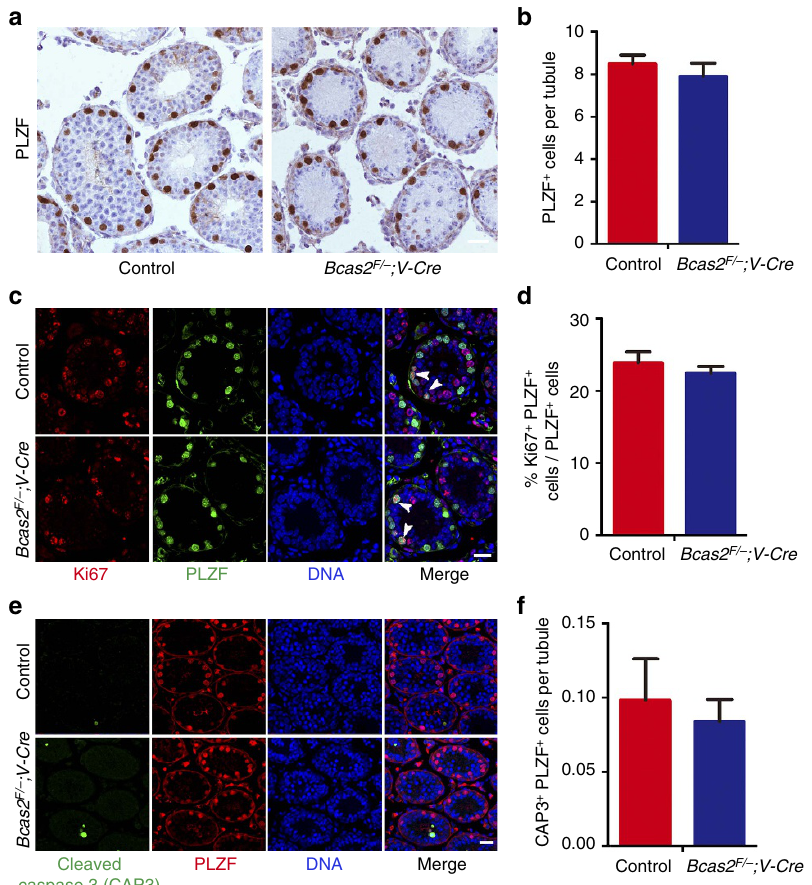
Figure 4 | Proliferation and apoptosis assay of spermatogonia. ( a ) Immunohistochemical assay of PLZF in control and Bcas2 F/ (cid:2) ;Vasa-Cre testes at P12. The DNA was stained with hematoxylin. Scale bar, 25 m m. ( b ) The number of PLZF þ cells per seminiferous tubules in control and Bcas2 F/ (cid:2) ;Vasa-Cre testes at P12. At least 500 tubules were counted from at least 5 different mice. Error bars represent s.e.m. ( c ) IF staining of the mitosis marker Ki67 in PLZF positive cells of control and Bcas2 F/ (cid:2) ;Vasa-Cre testes at P12. The DNA was stained with Hoechst 33342. Scale bar, 20 m m. Arrowheads indicate the representative Ki67 þ PLZF þ cells. ( d ) The ratio of Ki67 þ PLZF þ positive cells in PLZF þ cells of control and Bcas2 F/ (cid:2) ;Vasa-Cre testes at P12 (in %). At least 300 tubules were counted from at least 5 different mice. Error bars represent s.e.m. ( e ) IF staining of the apoptosis marker cleaved caspase 3 (CAP3) in PLZF þ cells of control and Bcas2 F/ (cid:2) ;Vasa-Cre testes at P12. The DNA was stained with Hoechst 33342. Scale bar, 50 m m. ( f ) The number of CAP3 þ PLZF þ cells per seminiferous tubules of control and Bcas2 F/ (cid:2) ;Vasa-Cre testes at P12 (in %). At least 150 tubules were counted from 3 different mice. Error bars represent